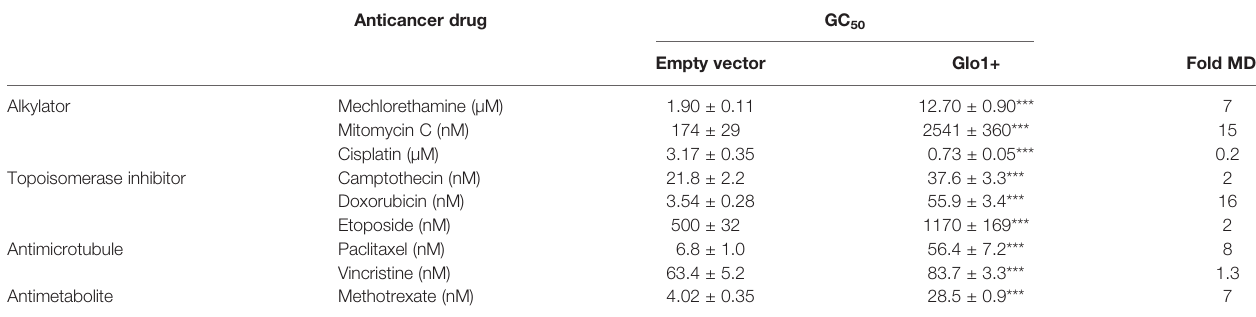
HEK293cellswithstabletransfectionbyemptyvector(Emptyvector)orvectorproducingfour-to fi vefoldincreasedexpressionofGlo1(Glo1+)wereincubatedwithandwithouttreatment with anticancer drugs, six different concentrations in triplicate, for 48 h. The median growth inhibitory concentration of the drug, GC 50 , was deduced by nonlinear regression of viable